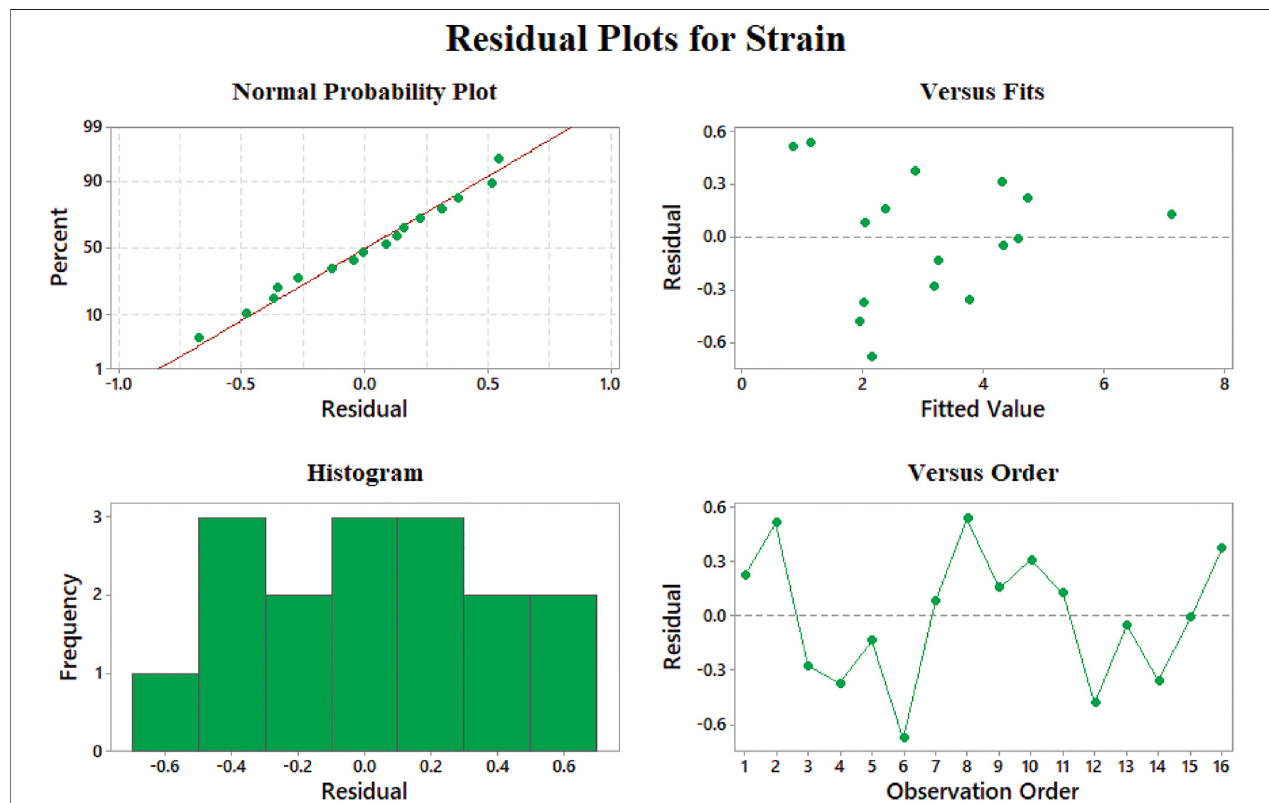
FIGURE 9 | Representing errors of the strain at rupture model: (A) normal probability, (B) versus fi t, (C) histogram, and (D) versus order.